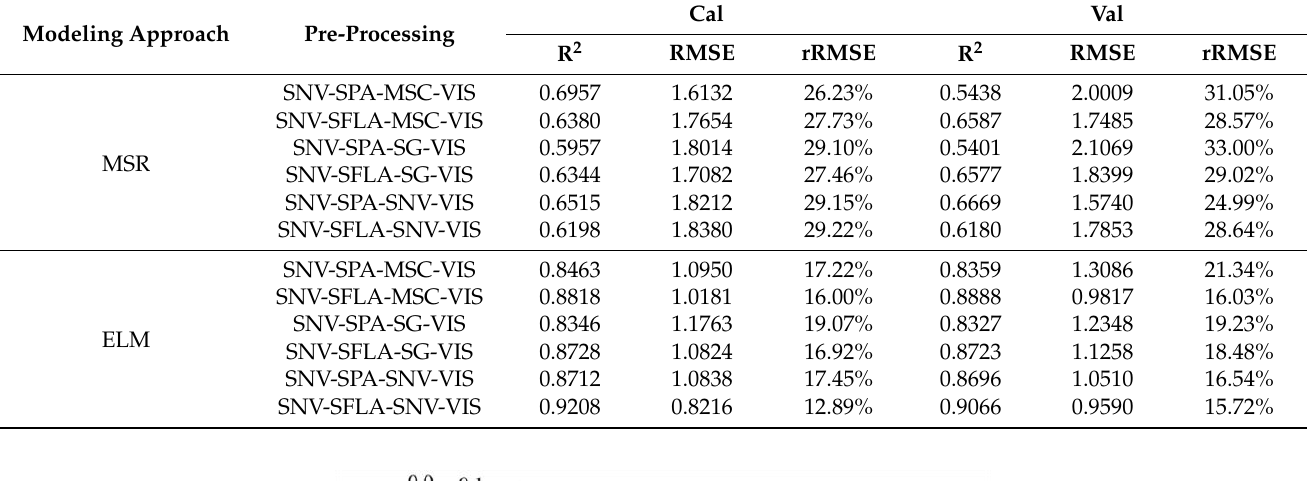
Table 8. Cotton LAI monitoring model training sets (Cal) and validation sets (Val) result based on spectral reflectance and vegetation indices.